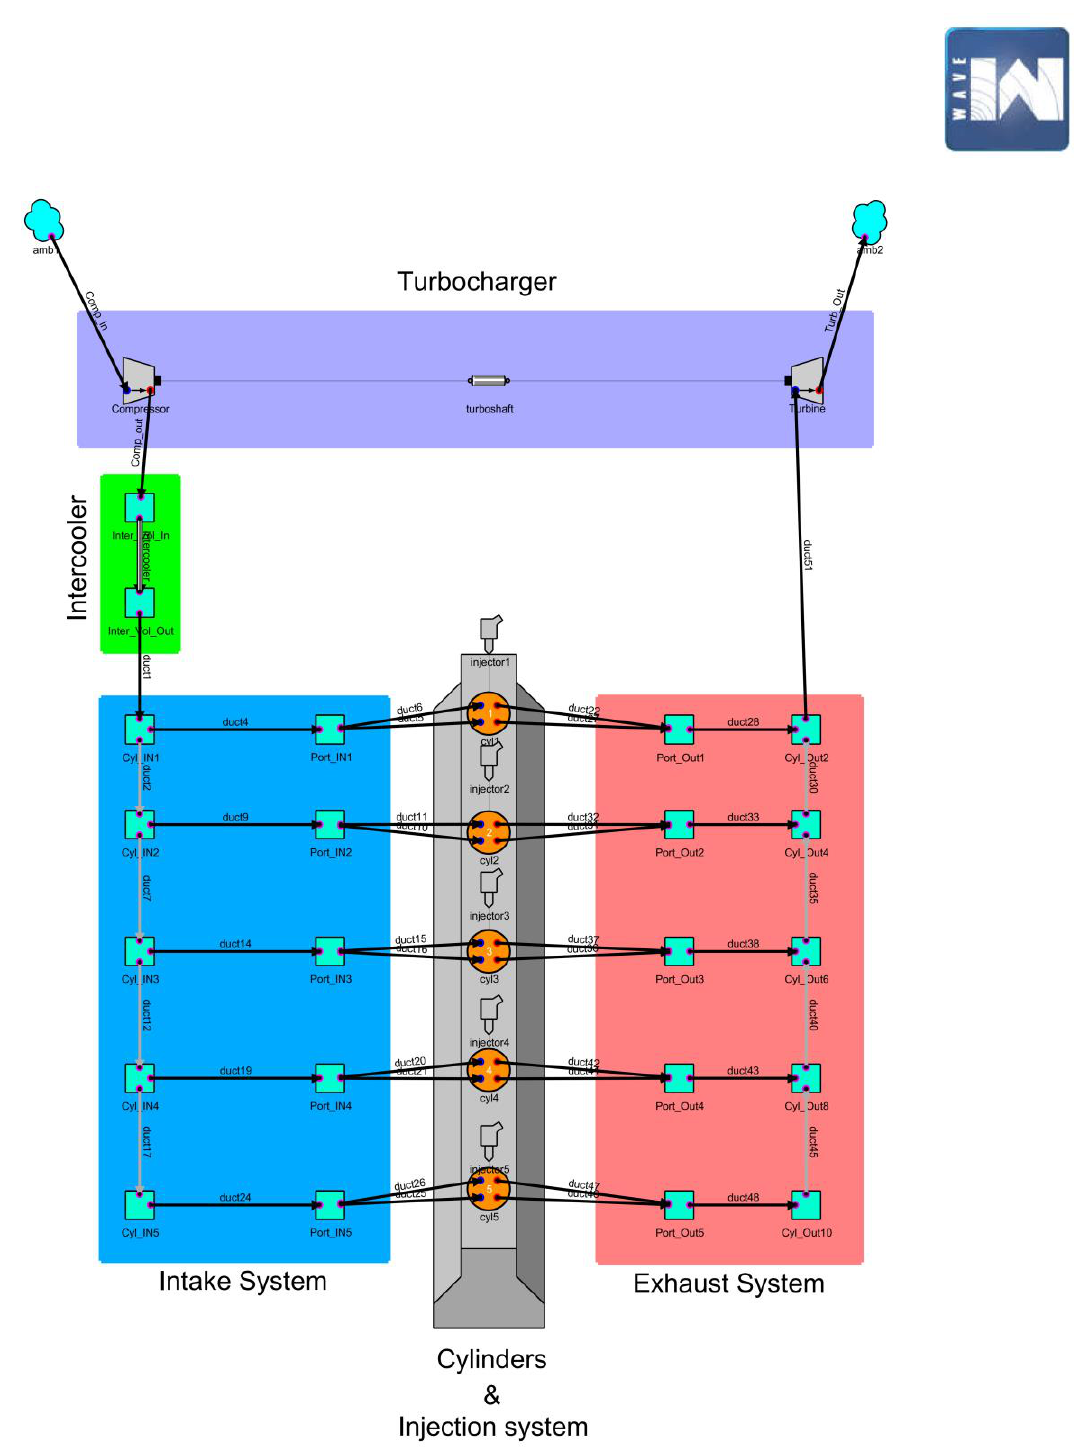
Figure 5. Engine model established in Ricardo Wave.